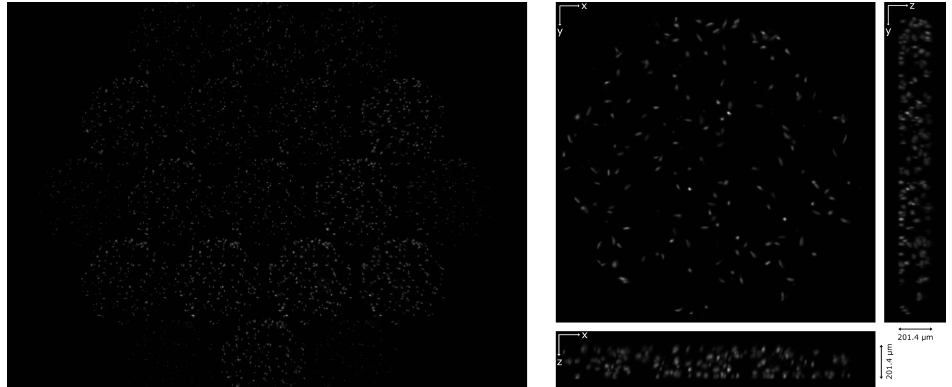
Figure 8. Living phytoplankton. On the left, the first frame of the video recorded through the light- field eyepiece. On the right, the corresponding reconstruction: the Z projection and the orthogonal views are shown.